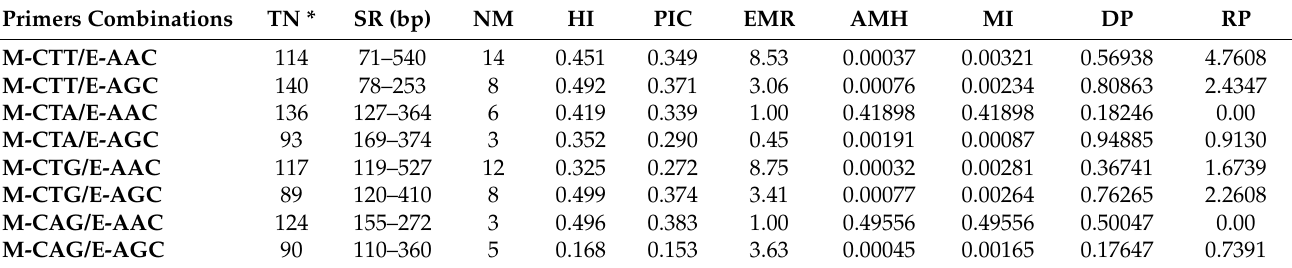
Table 4. AFLP marker data